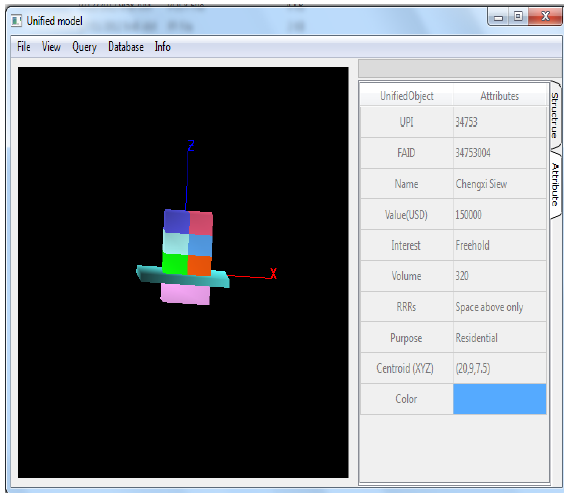
Figure 7. Application for 3D cadastre.